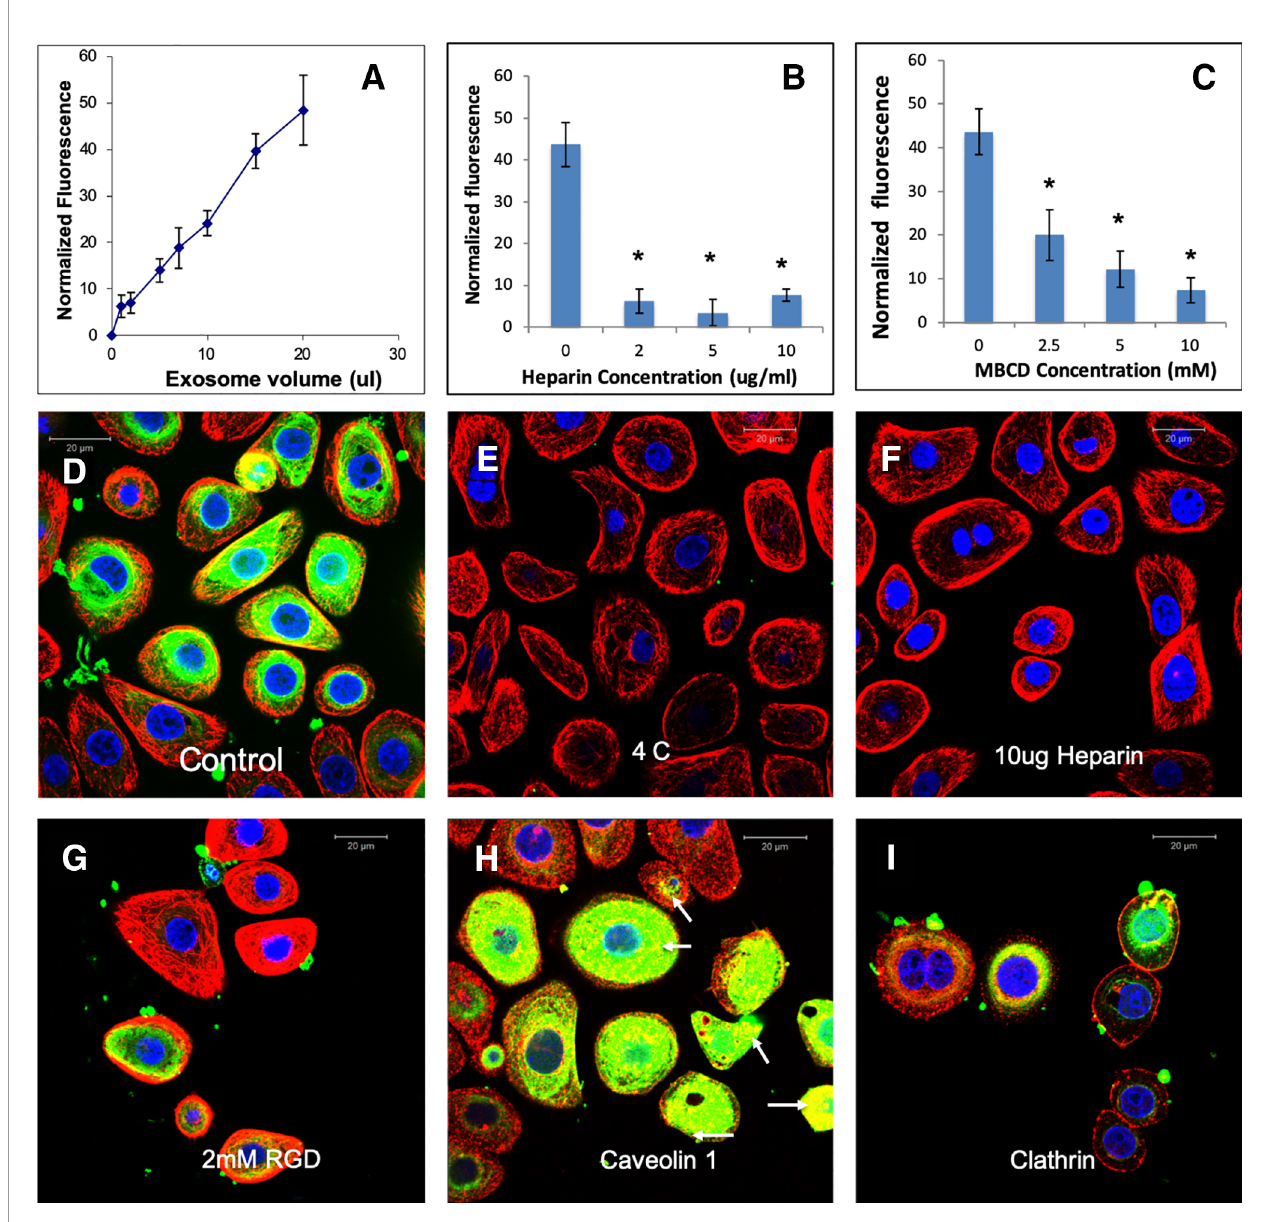
FIGURE 5 | Endocytosis of human mesenchymal stem cell (HMSC) extracellular vesicles (EVs) by TIGK gingival keratinocytes: (A) Graphical representation of dose- dependent and saturable endocytosis of fl uorescently labeled HMSC EV by TIGK cells. Data points represent mean fl uorescence (n=6) +/ − SD. The EV volume was standardized as described under the methods section. (B) Graph showing the dose dependent inhibition of HMSC EV endocytosis after pre-treatment of the EVs with heparin to block interaction with the cell surface HSPGs. Data represent mean percentage fl uorescence with respect to control +/ − SD. (C) Graph showing the reduction in HMSC endocytosis after disruption of target cell membrane cholesterol with varying doses of methyl- b -cyclodextrin (MBCD). Data is presented as mean percentage fl uorescence with respect to control +/ − SD. Representative confocal micrograph depicting the endocytosed fl uorescently labeled HMSC EVs within target HMSCs after 1 h of incubation at 37°C. (E) Representative confocal micrograph indicating the abrogation of HMSC EV endocytosis when the experiment is performed at 4°C. (F) Representative confocal micrograph showing that pre-treatment of EVs with heparin blocks HMSC EV endocytosis. (G) Representative confocal micrograph of HMSC EV endocytosis after pre-treatment of the cells with 2 mM RGD peptide to block cell surface integrins. In images (D – G) , green fl uorescence represents endocytosed EVs. Red fl uorescence represents tubulin counter stain and blue fl uorescence indicates 4 ′ ,6-diamidino-2-phenylindole (DAPI) nuclear stain. (H) Confocal micrograph showing colocalization of endocytosed HMSC EVs (green) with caveolin1 (red). (I) Confocal micrograph showing the absence of co-localization between endocytosed EVs (green) and clathrin (red). * represents statistical signi fi cance (P < 0.05, ANOVA followed by Tukey ’ s ad-hoc ) with respect to